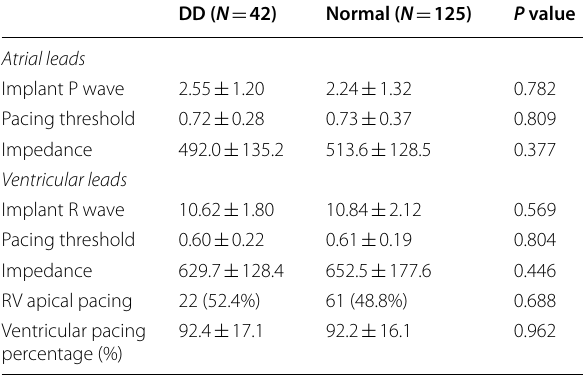
Table 2 Device-related parameters